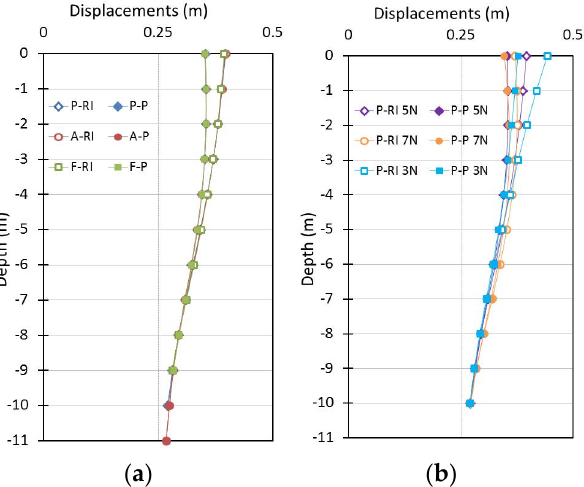
Figure 16. Displacements in the rigid inclusion and pile systems with different support conditions. ( a ) 5-storey Building; ( b ) 3-, 5- and 7-storey Buildings.